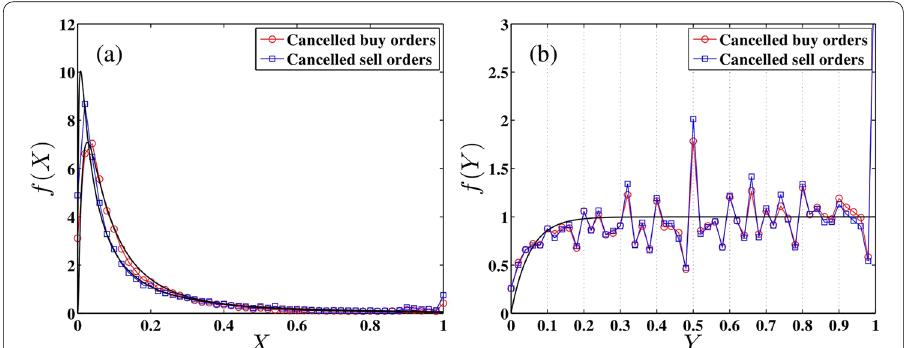
Fig. 5 Determination of the order cancellation process. a Probability density functions f ( X ) of relative price levels on the LOB for both canceled buy and sell orders of stock 000001. The solid lines are fits to the rescaled log‑normally distribution. b Probability density functions f ( Y ) of relative temporal positions at all price levels for both canceled buy and sell orders of the same stock. The solid line is the fit to an exponential function